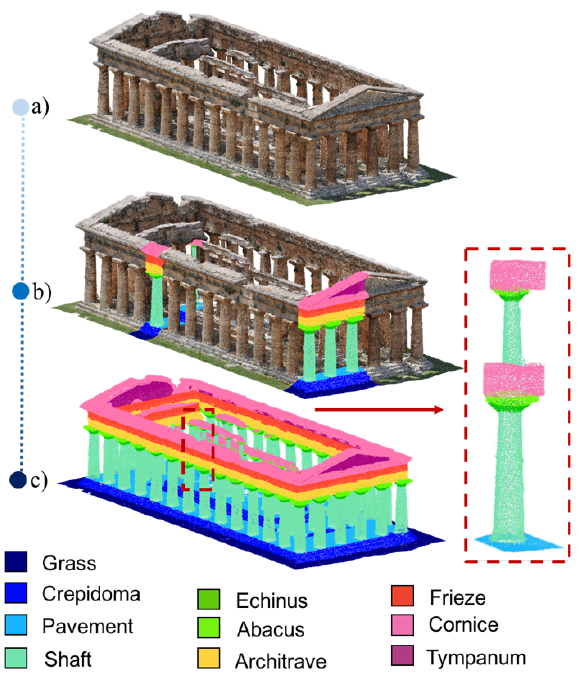
Figure 6: Temple of Neptune point cloud (a), annotated (b) and classified (c).